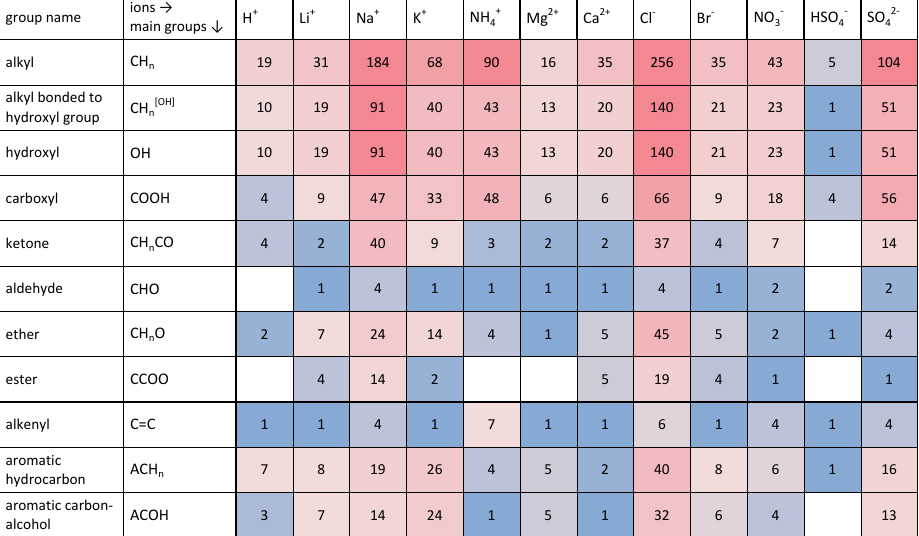
[ alc ] [ alc − tail ] ↔ ion interaction n and CH n , as they share the same main group